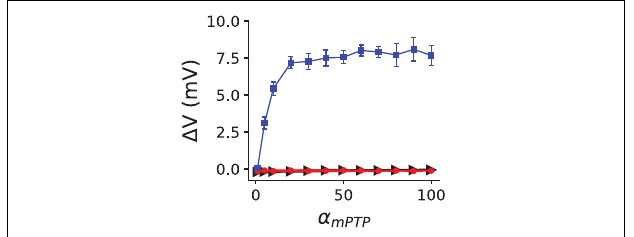
FIGURE 2 | The Redox effect of cytosolic ROS on RyR facilitates the genesis of DADs. The mean and standard deviation of the DAD amplitude vs. α mPTP for three different conditions: clamped cytosolic ROS level at 1.0 µ M (red circles), the redox effect of ROS only exerted on RyRs (blue squares), and the redox effect of ROS only exerted on SERCA (black triangles). The removal of the redox effect of ROS on RyRs and SERCA was executed by setting (cid:52) k ROS = 0 in Eq. 2, and f up , ROS = 1 in Eq. 5, respectively. Ten random trials were performed for each given α mPTP value.